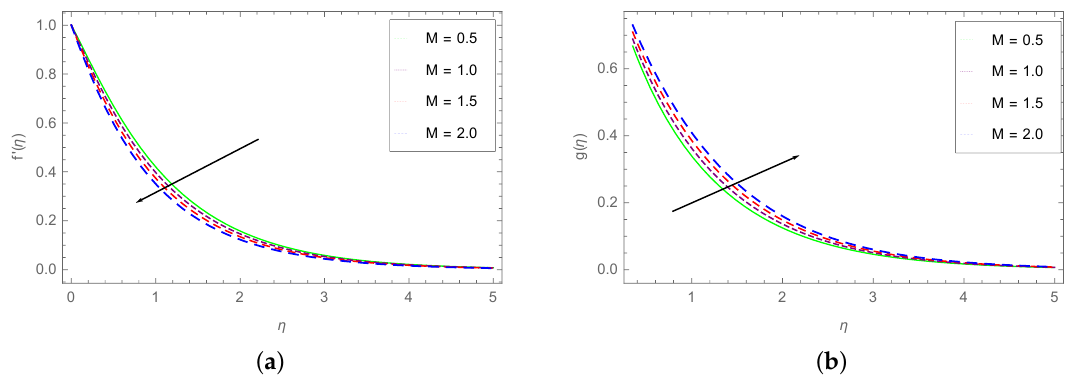
Figure 2. ( a ) f (cid:48) ( η ) variation with M , and ( b ) g ( η ) dependence on M .